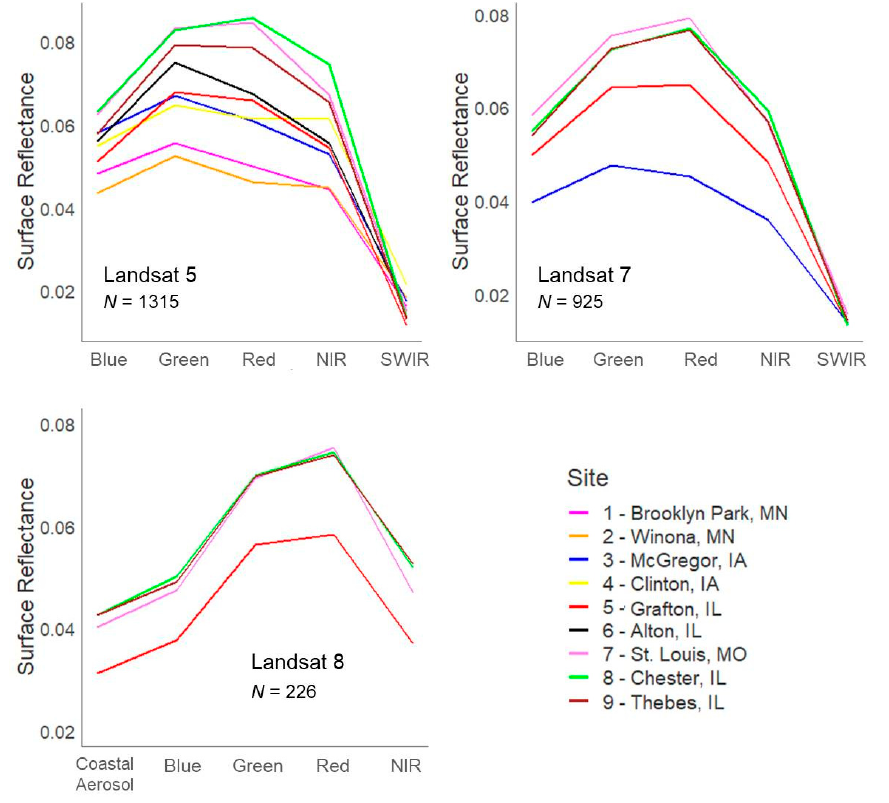
Figure 6. Mean surface reflectance at each study site obtained from the three Landsat missions.